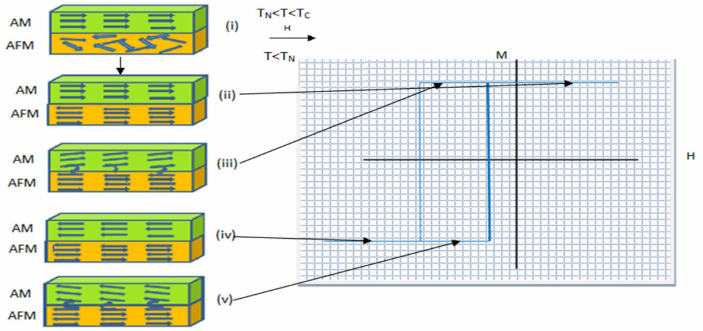
Figure 3. Schematic diagram of the spin valve configuration of FM/AFM (a) at different stages (i) to (v) of an exchange biased hysteresis loop by Nogues et al.